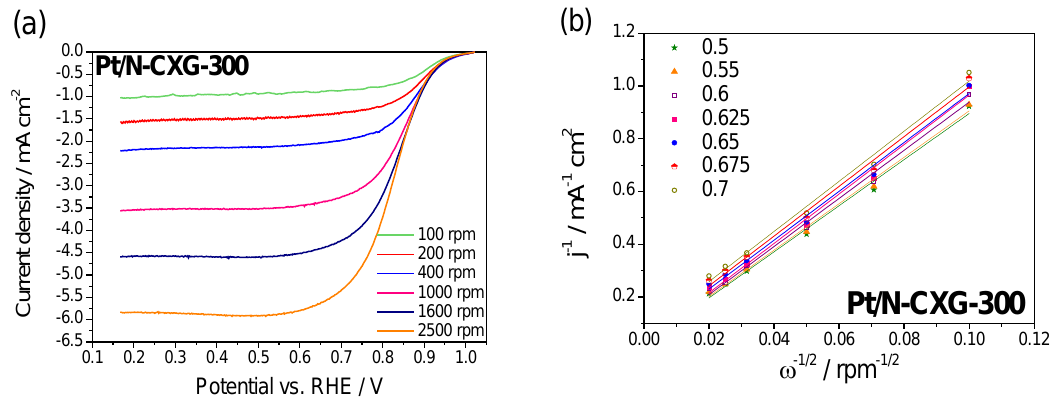
Figure 7. ( a ) Linear sweep voltammetries (LSV) curves for Pt/N-CXG-300 at different rotation rates recorded in a 0.5 M H 2 SO 4 O 2 -saturated solution. Scan rate: 5 mV · s − 1 ; ( b ) Koutecky-Levich plots for Pt/N-CXG-300 at different potentials. The legend refers to potential values (V vs. RHE).